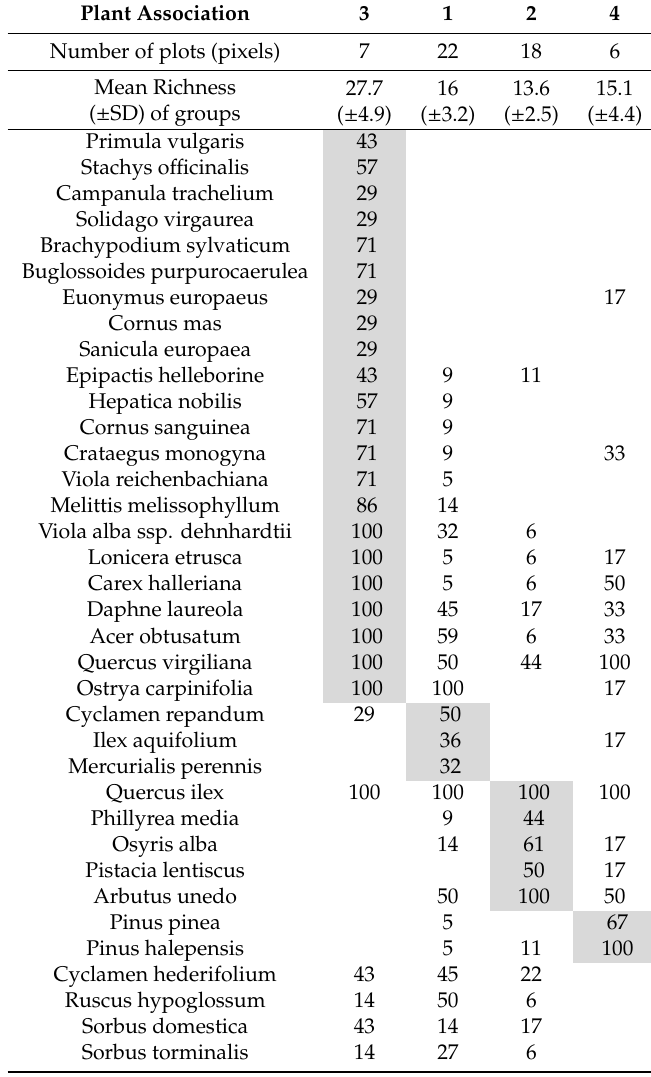
Table A1. Summary frequency table (percentage) of species composition of the 4 clusters (plant associations) identified by the hierarchical cluster analysis on 53 field phytosociological relev é s of the forestsofMountConero(Marche, CentralItaly). Plantassociations: 1, Cephalantherolongifoliae-Quercetum ilicis ; 2, Cyclamino hederifolii-Quercetum ilicis ; 3, Asparago acutifolii–Ostryetum carpinifoliae ; 4, Pinus halepensis and P. pinea reforested plantation. Species with at least 25% of frequency are reported. In gray the species indicators ( phi ≥ 0.4, p -value <